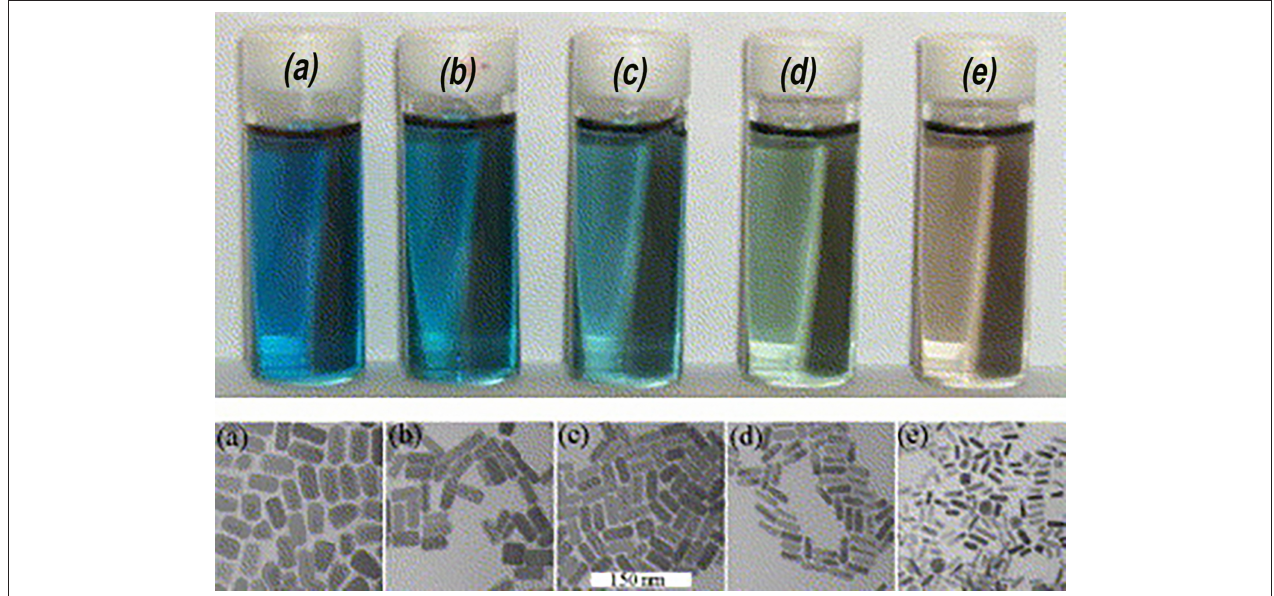
FIGURE 2 | Color of gold nanorods with different aspect ratios. The small difference in the aspect ratio shows distinctive transmitted colors in the samples. Re-printed with permission from Elsevier 2005 (Pérez-Juste et al.,